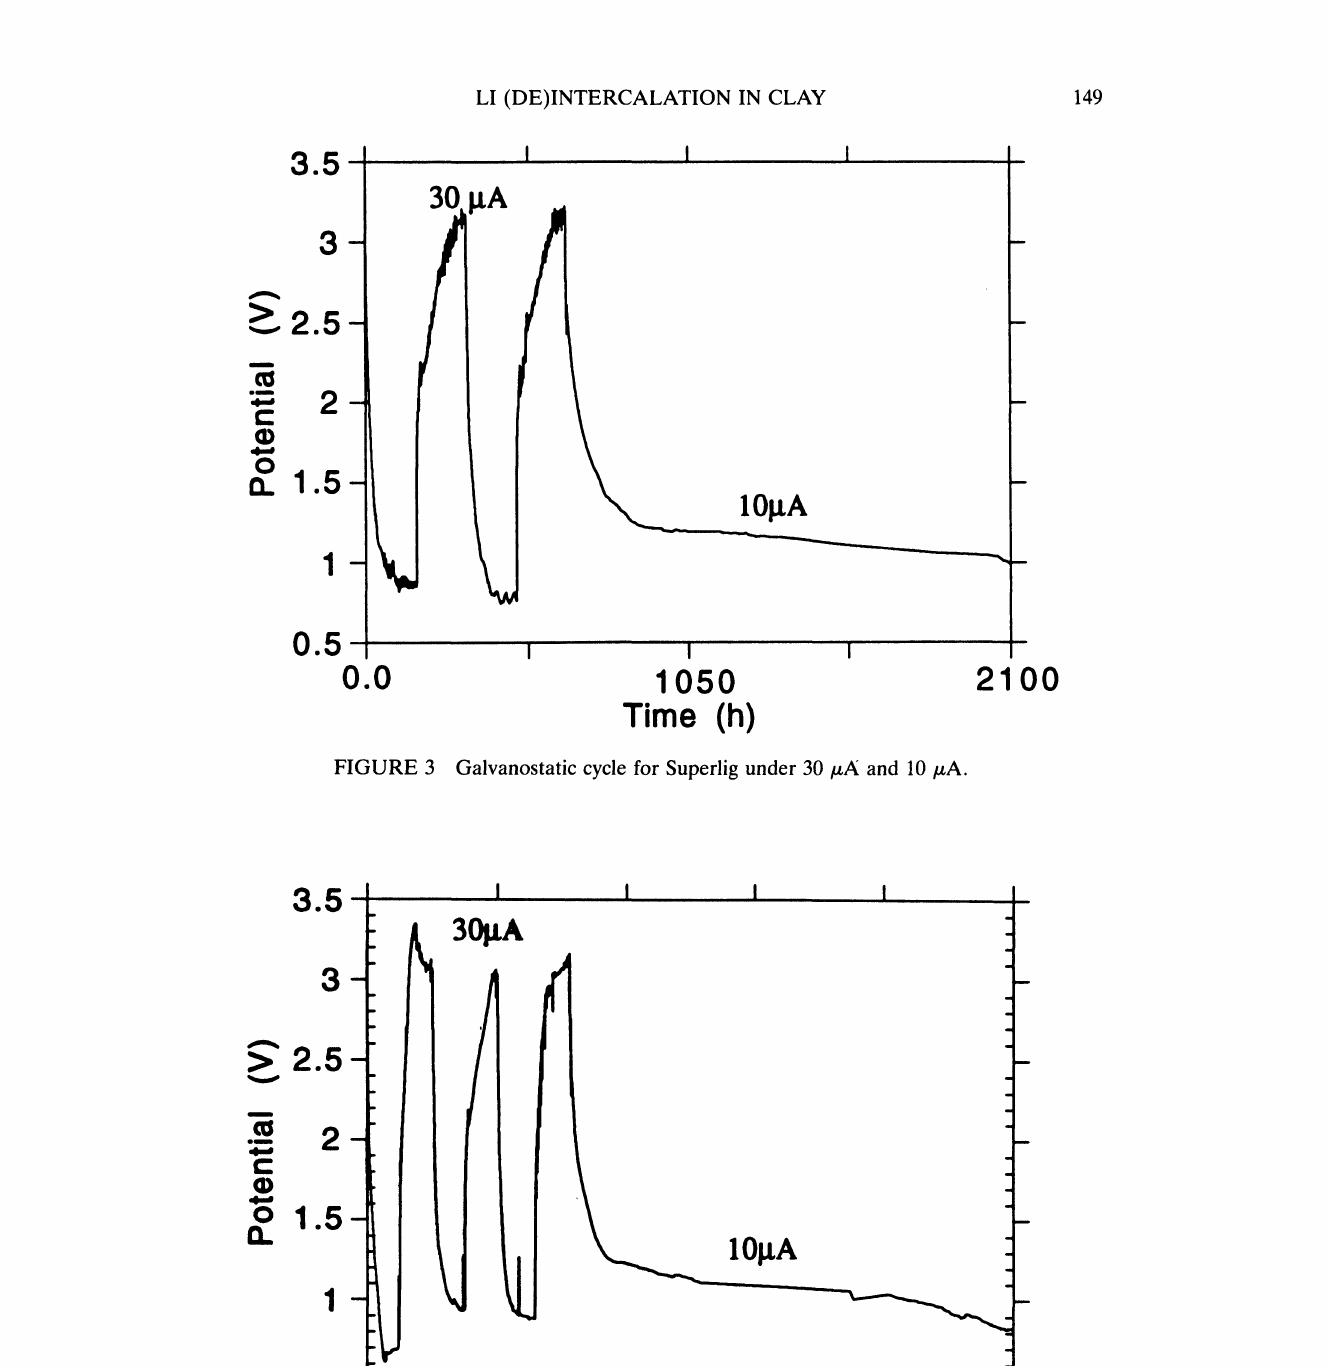
FIGURE 4 Galvanostatic cycle for VSP-200 under different